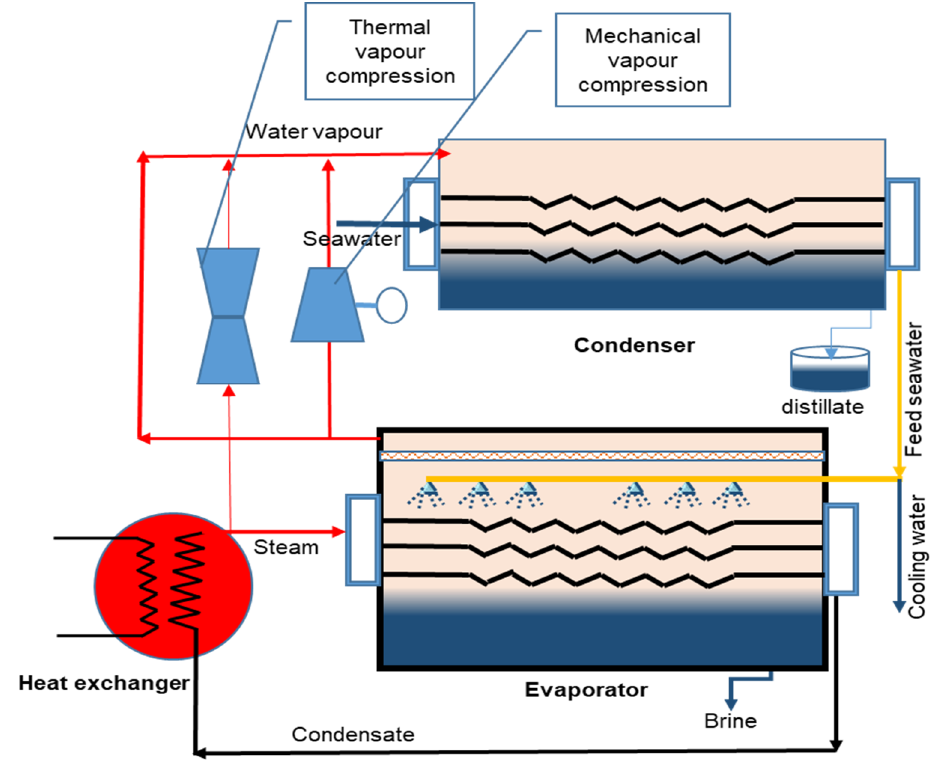
Figure 9. Single stage evaporation with thermal/mechanical vapor compression.